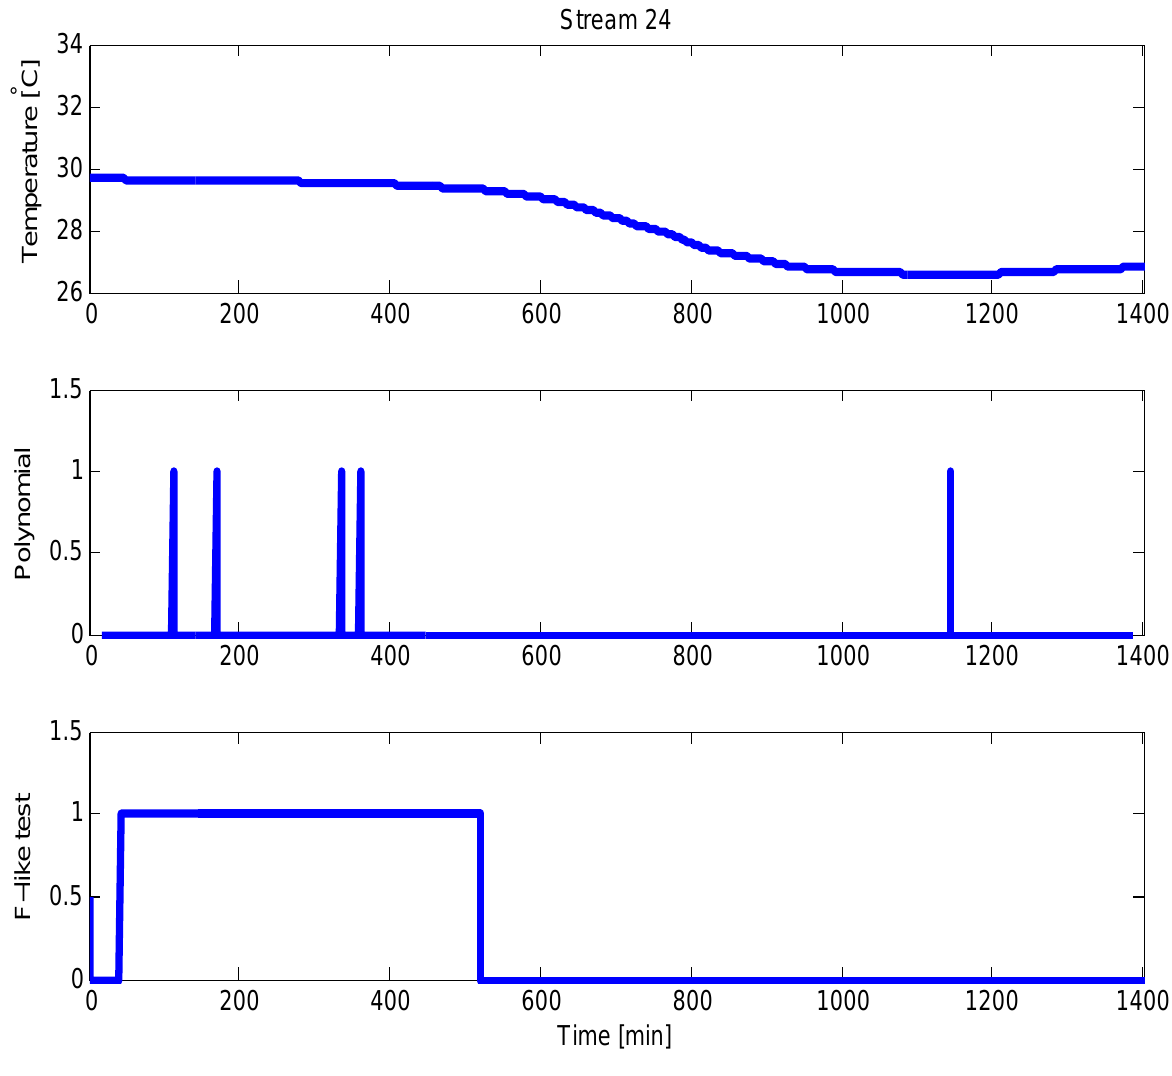
Figure 11. Depropanizer reflux drum case temperature experimental data and SSI results for the F-like test and the polynomial